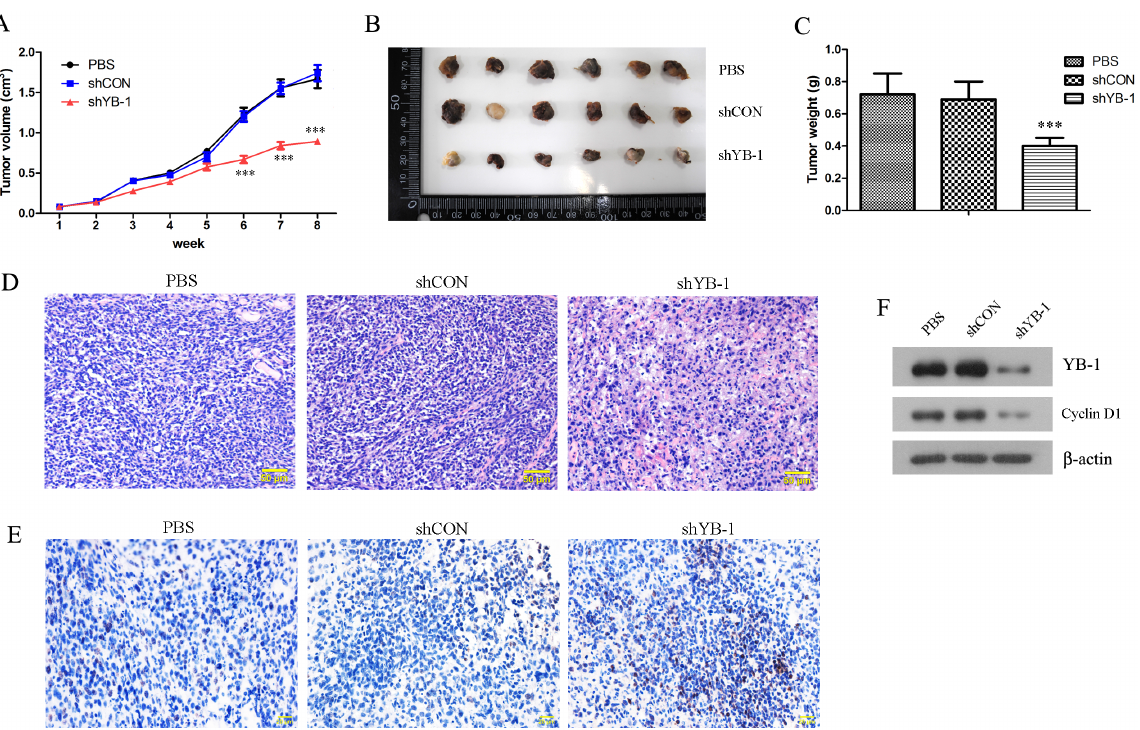
Fig 6. Targeting YB-1 by intra-tumor shRNA injection inhibited tumor growth in mice. SH-SY5Y cells were inoculated subcutaneously to 8-week-old mice at 10 6 per mouse. When the tumors grew to approximately 100 mm 3 , the mice were randomly assigned to receive an intra-tumor injection of PBS, shCON plasmids or shYB-1 plasmids (n = 6 each group). (A) Tumor volumes were measured every week for 8 weeks from the day of shRNA injection. (B, C) Upon termination of the experiment at post-treatment week 8, the mice were sacrificed, and the tumors were excised, photographed and weighed. (D) Tumor tissues were fixed, paraffin embedded, sectioned and stained with hematoxylin and eosin (H&E) for histological examination. (E) TUNEL assay was performed to detect apoptotic cells in the tumor tissues. (F) Expression levels of YB-1 and Cyclin-D1 in the tumor tissues were assessed by Western blot analysis. D-F show representative images from all the mice examined. Values are expressed as mean ± standard deviation. Compared with PBS control, *** P < 0.001.